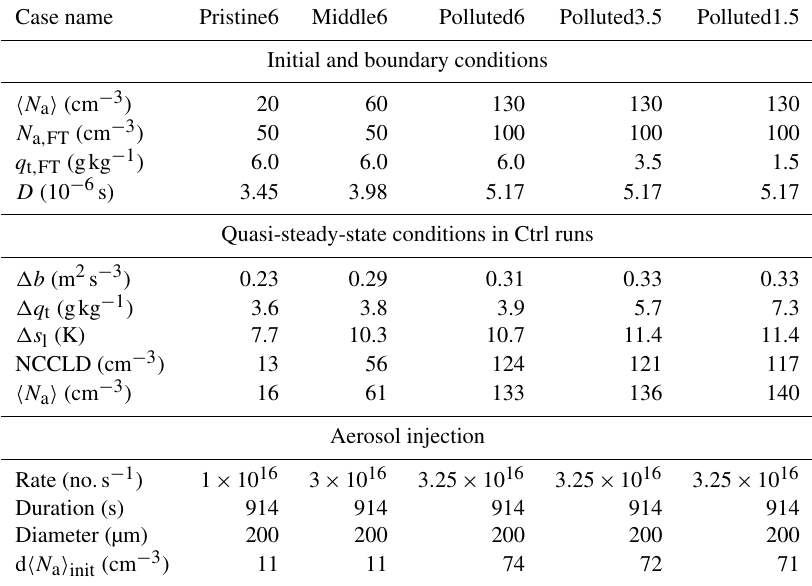
Table 1. Conditions used for the Pristine6, Middle6, Polluted6, Polluted3.5, and Polluted1.5 cases. The upper section of the table summarizes the initial and boundary conditions, the middle section summarizes the quasi-steady-state conditions in Ctrl runs, and the lower section summarizes the information on aerosol injections.